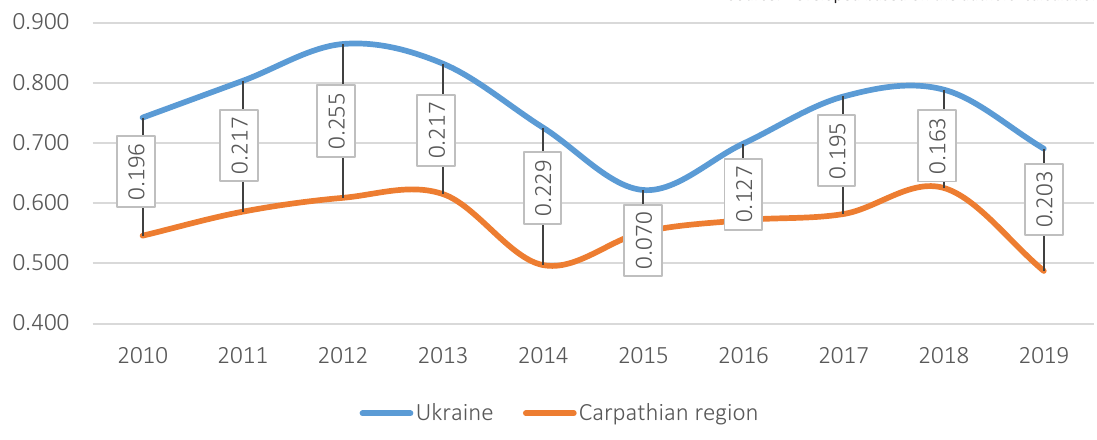
Figure 1. The variable scope of the population’s social resilience environment in Ukraine and the Carpathian region,